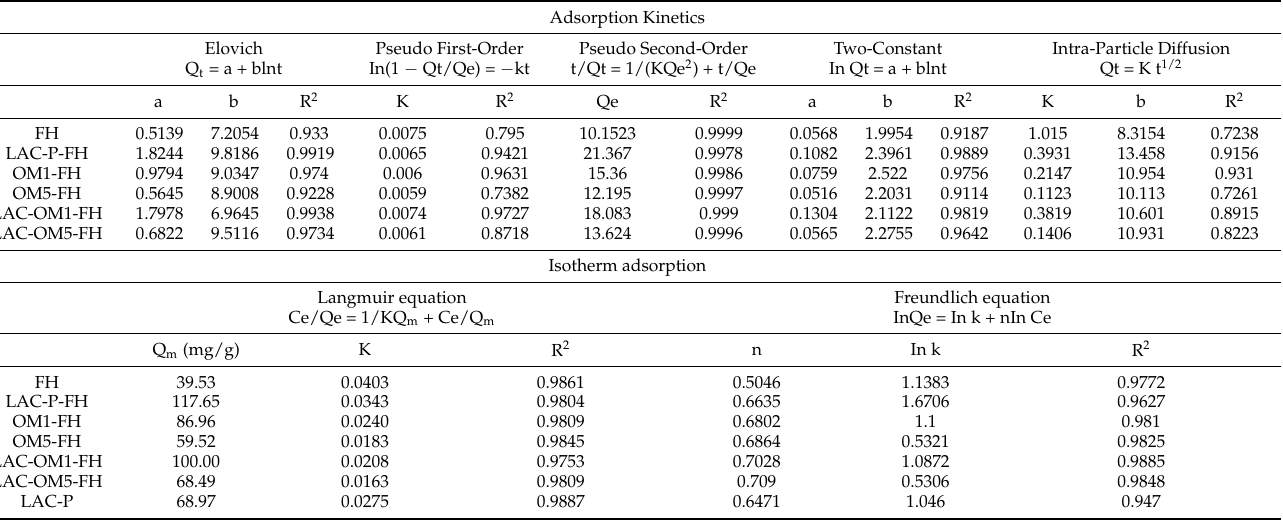
Table 1. Fitting data of adsorption kinetics and isotherms adsorption of Cd onto FH and Fe-OM associations. Adsorption